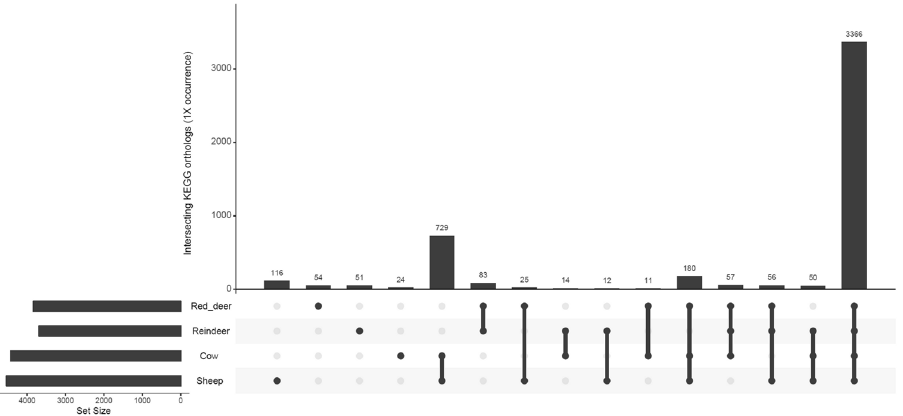
Figure 8. UpSetR graph showing the number of shared KEGG orthologs families at average ×1 coverage within four ruminant